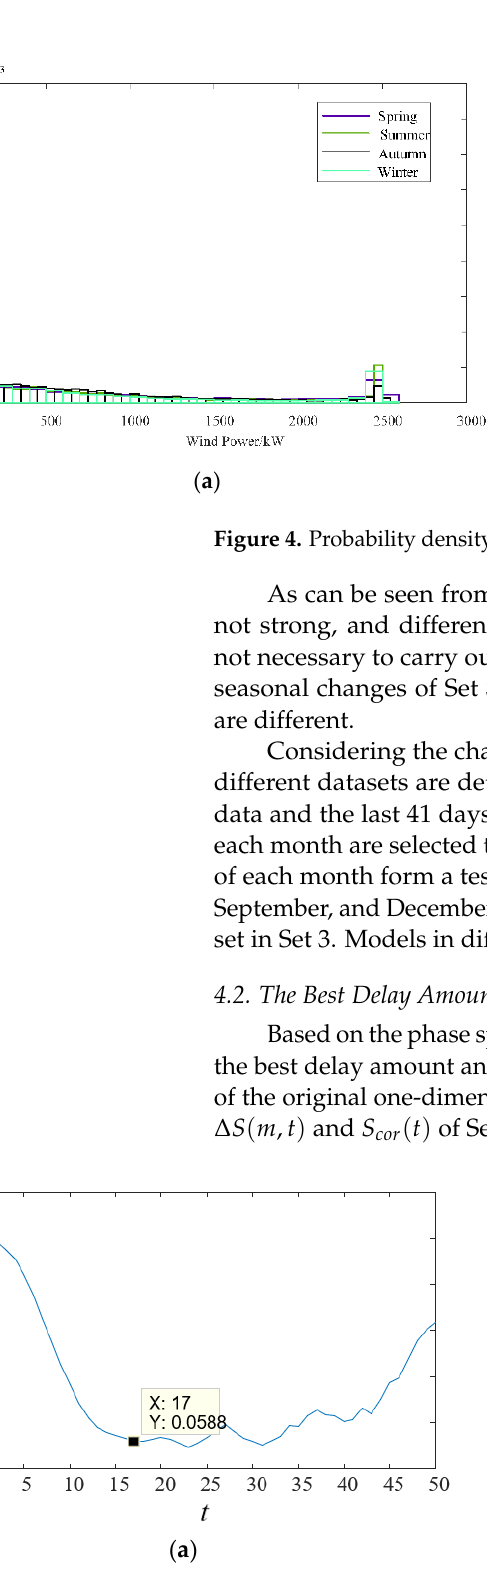
Figure 5. Statistics curves with C-C phase method: ( a ) ( , ) S m t  ; ( b ) ( )